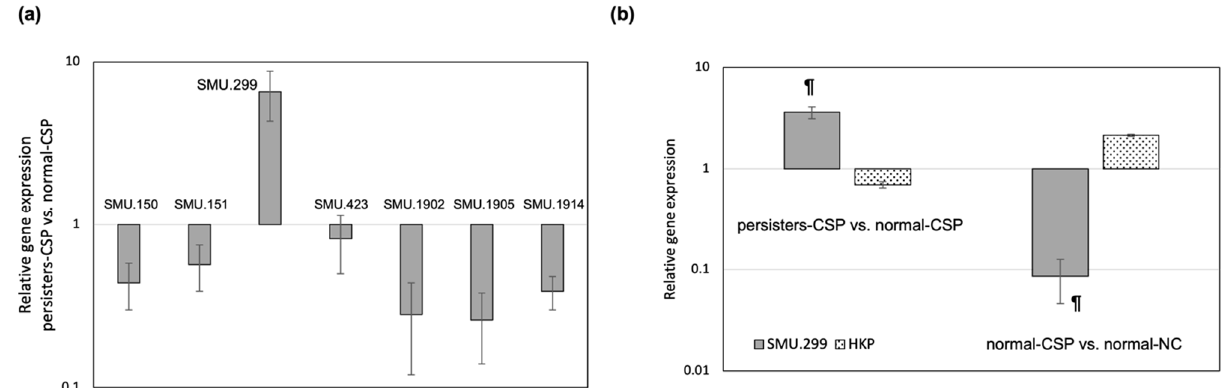
Figure 1. Gene expression analysis by qRT-PCR. ( a ) Relative expression level of putative GG-type leader bacteriocin genes in persisters-CSP. SMU number corresponds to NCBI designation for that particular ORF in the reference sequence (AE014133.2). Bacterial cells were incubated with the CSP pheromone for 2 h and treated with ofloxacin for 24 h to kill all nonpersisters. Control cultures were normal-CSP cells. ( b ) Relative expression level of gene SMU.299. The gene encoding the gyrase subunit B was used as housekeeping (HKP) control gene. The data are the average of three independent experiments ± standard error. ¶ denotes statistical significance between SMU.299 and HKP under the same